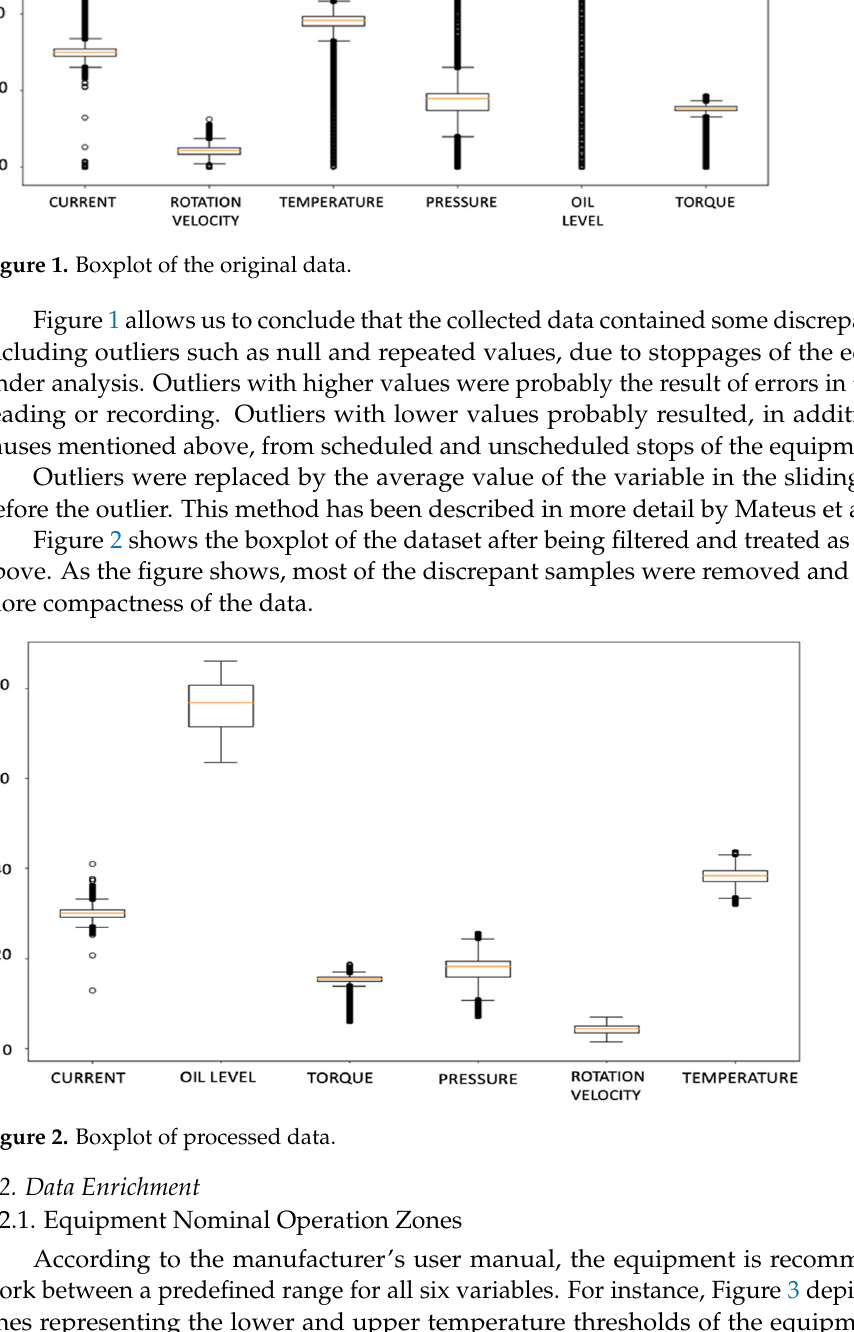
Figure 1. Boxplot of the original data.